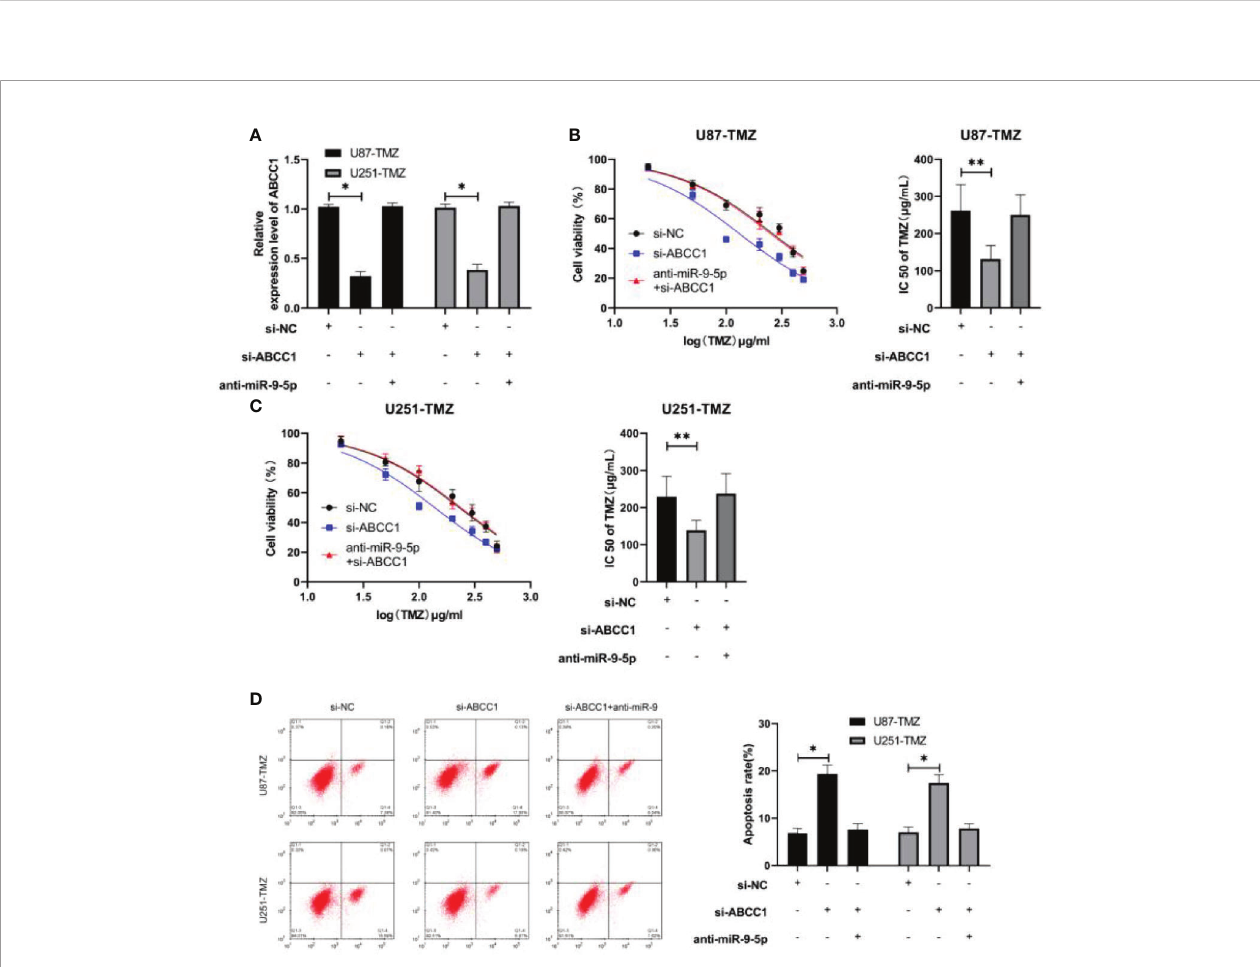
FIGURE 4 | miR-9-5p can reverse the sensitization of ABCC1 to glioma TMZ. (A) qRT-PCR was used to detect the relative expression of ABCC1 in U87-TMZ/ U251-TMZ cells after co-transfection. (B, C) The activity and IC50 of U87-TMZ/U251-TMZ cells were detected by MTT assay. (D) The change of apoptosis rate of U87-TMZ/U251-TMZ cells after co-transfection was detected by fl ow cytometry. * indicates P < 0.05; ** indicates P <